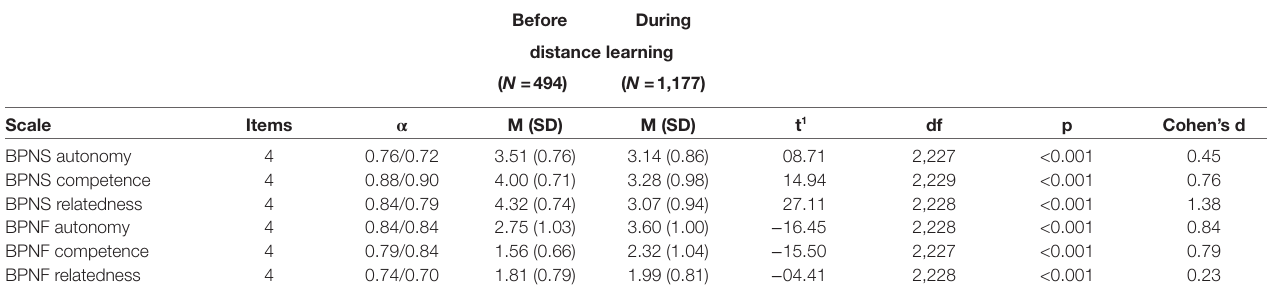
TABLE 2 | Basic psychological need satisfaction (BPNS) and basic psychological needs frustration (BPNF) before and during the distance learning period. Before